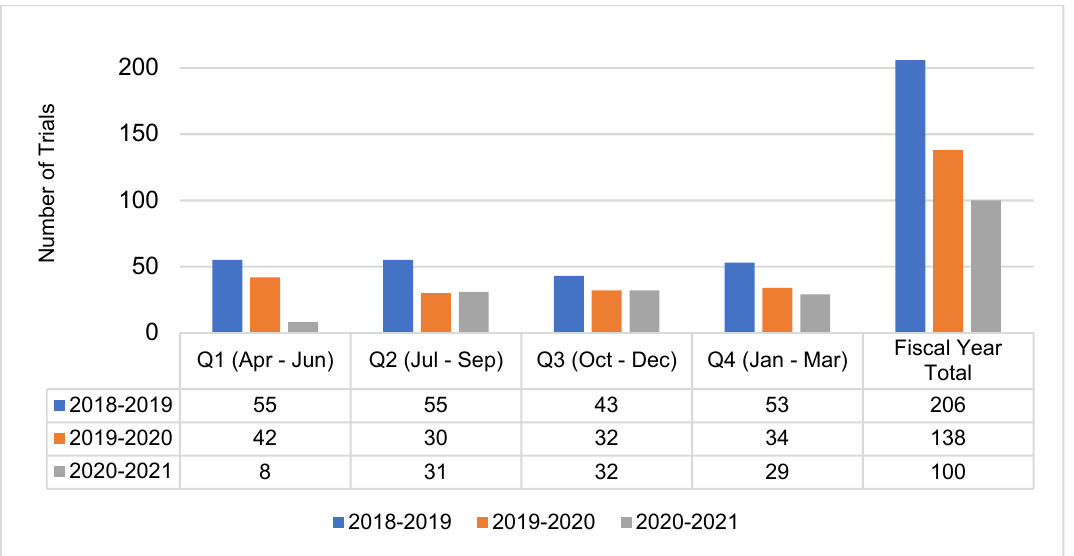
Figure 2. Trial site activations at adult Network centers ( n = 41) from 1 April 2018–31 March 2021.